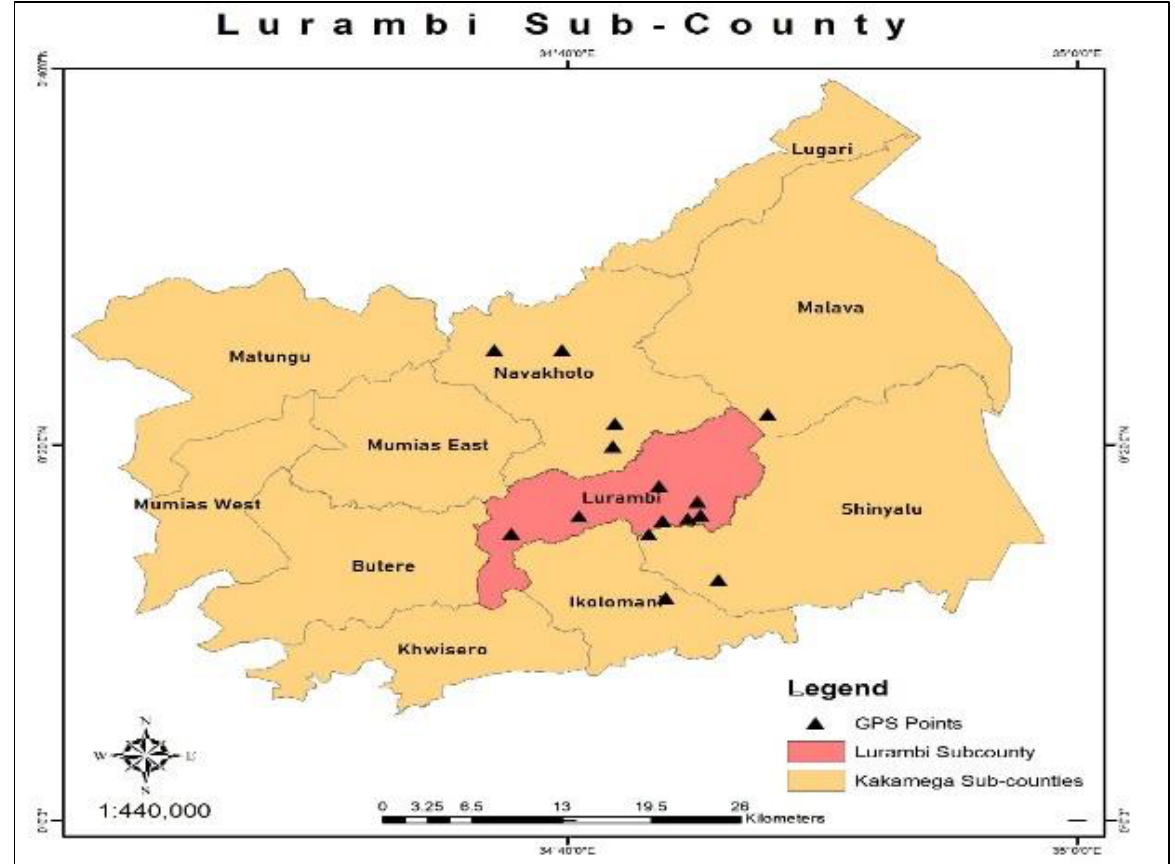
Figure 1: Map of the Lurambi Sub County and its Neighboring Sub Counties. Source: [6].